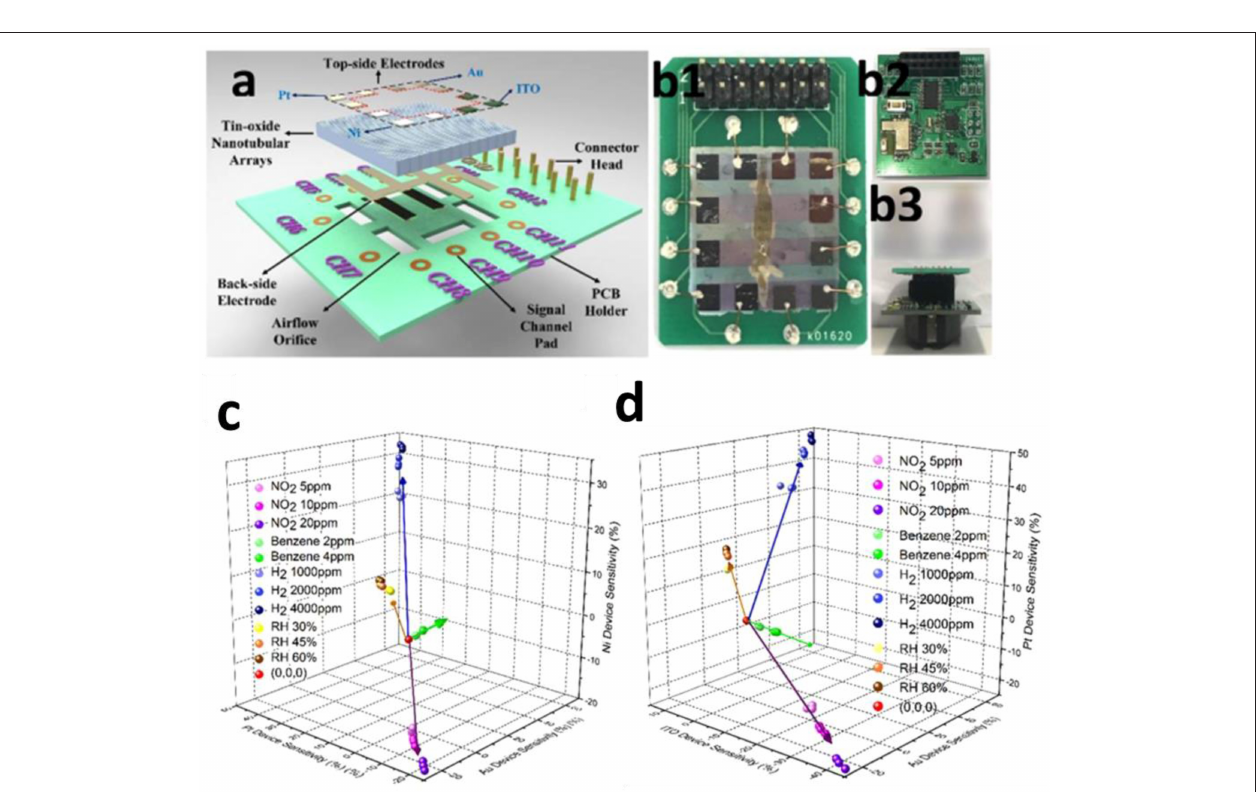
FIGURE 12 | (a) Schematic of E-nose device fabrication. (b) Photograph of integrated circuit of sensor system. The 3D scatter plot (c,d) of gas classification in cubic maps through LVQ analysis. Reprinted with permission from Chen et al. (2018), copyright 2018 American Chemical